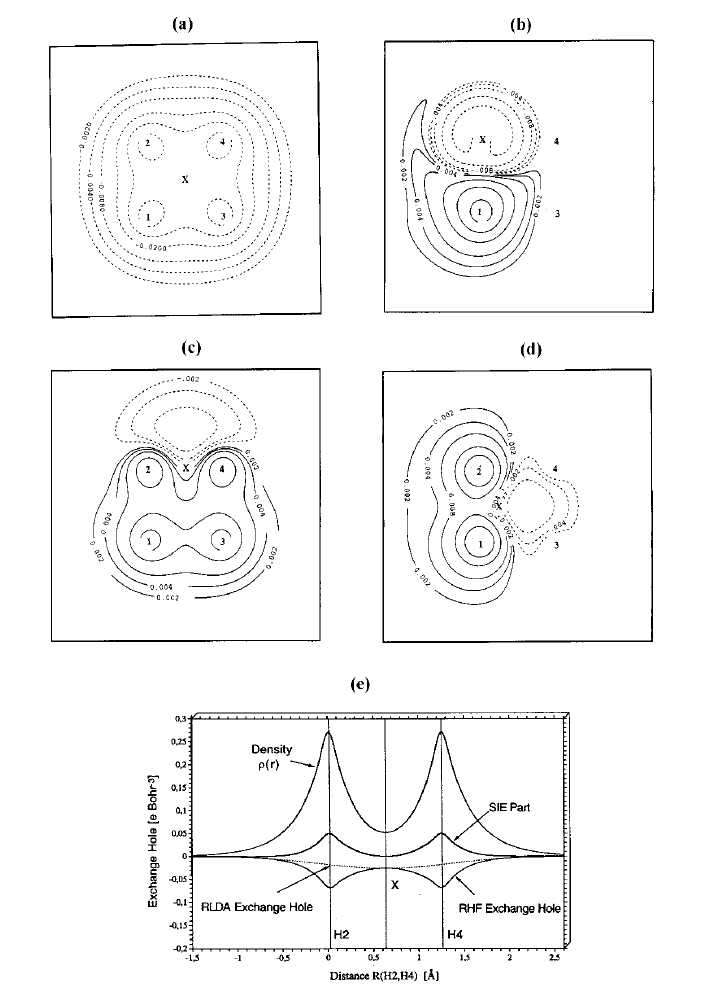
Figure 4: Contour line diagrams of the exchange hole of the reaction complex H 2 + H 2 calculated with the cc-pVTZ basis at a geometry close to the transition state (R(H1-H2) = 1.212; R(H2-H4) = 1.244 ˚A). The contour line levels have to be multiplied by the scaling factor 0.01 and are given in e bohr − 3 . a) RHF exchange hole. The reference electron (X) is at the center of the reaction complex. b - d) The part of the Slater exchange hole due to the self-interaction error. The reference electron X is at nucleus H2 ( b ), between H2 and H4 ( c ) or close to the bond H1-H2 ( d ). e) One-dimensional representation of the exchange hole calculated along the internuclear axis H2,H4. The reference electron X has the same position as in c